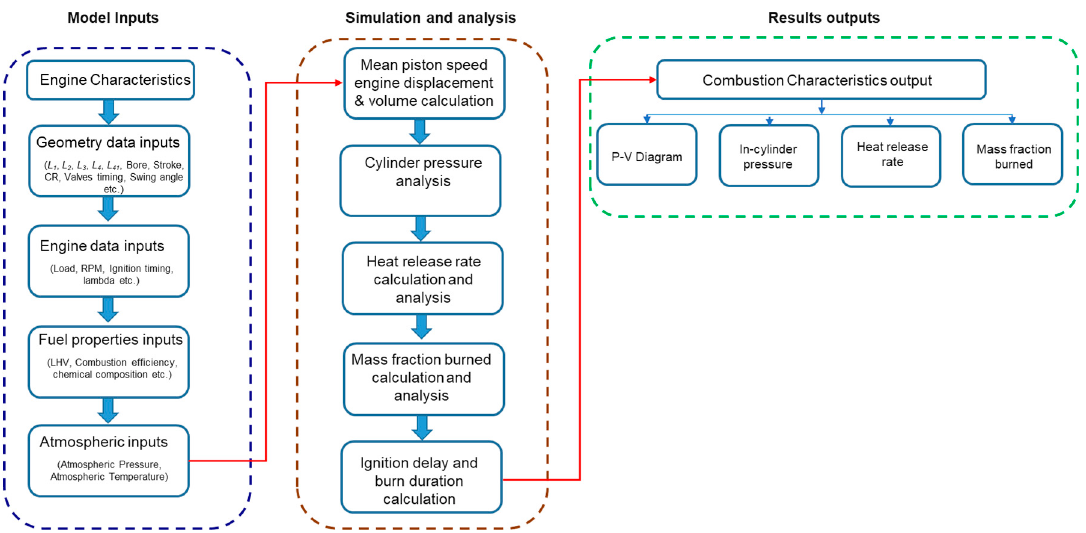
Figure 4. Flow chart of the CR engine model description.